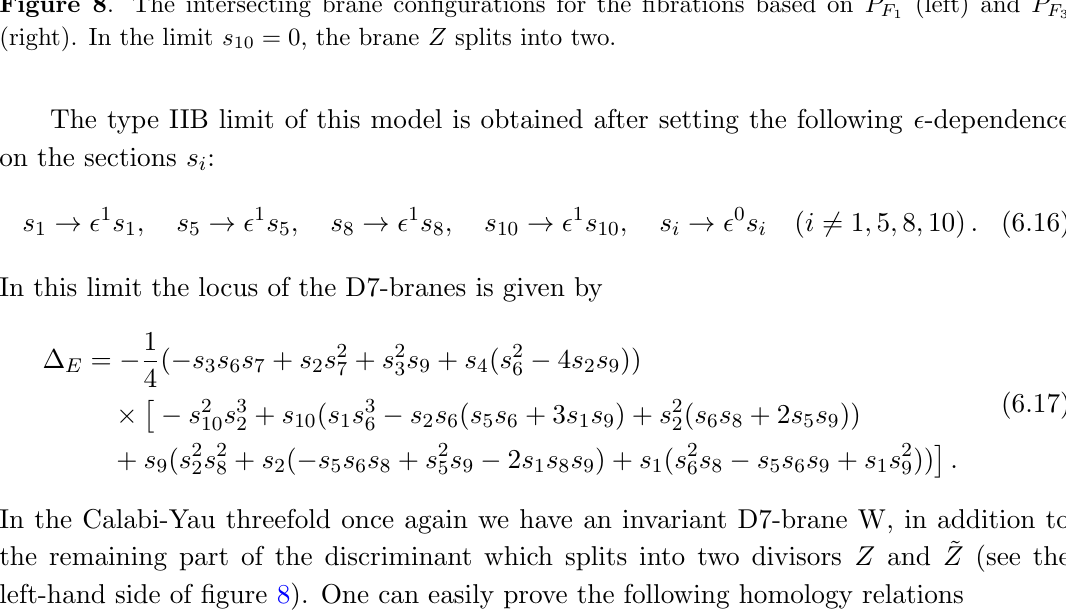
(left) and P F 1 3